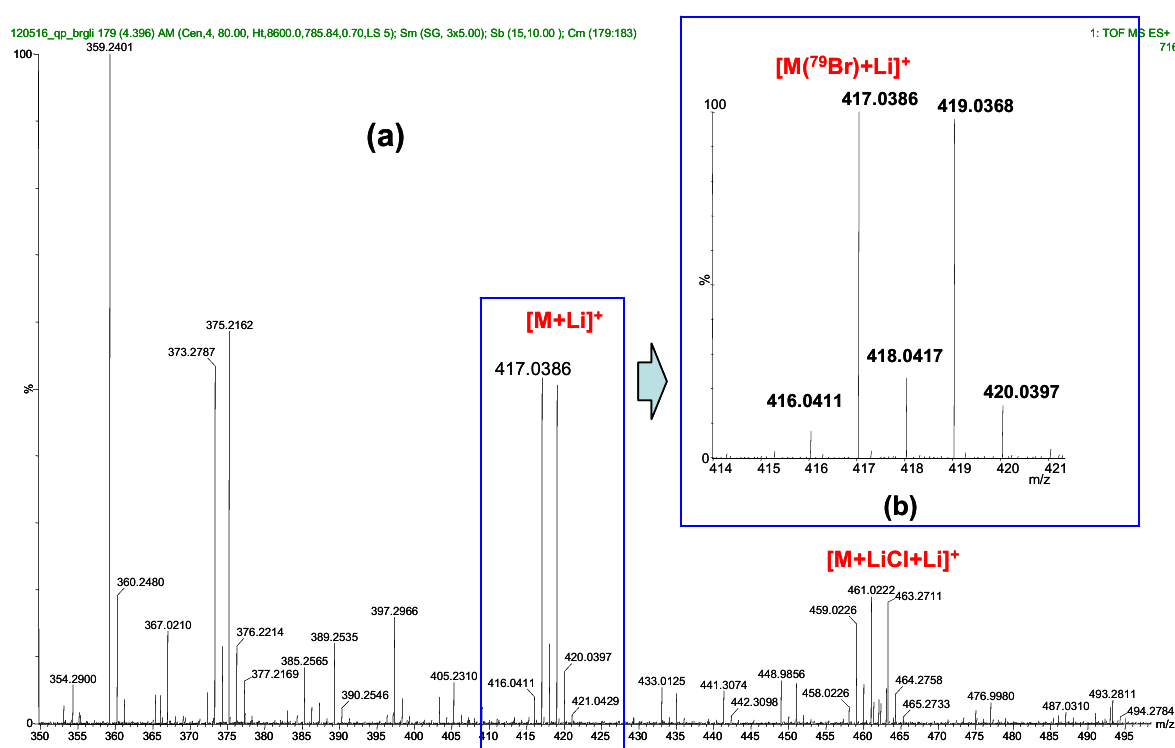
Figure 4. ( a ) A calibrated spectrum of analyte 2 and ( b ) the zoomed [M+Li] + peaks for accurate mass determination.